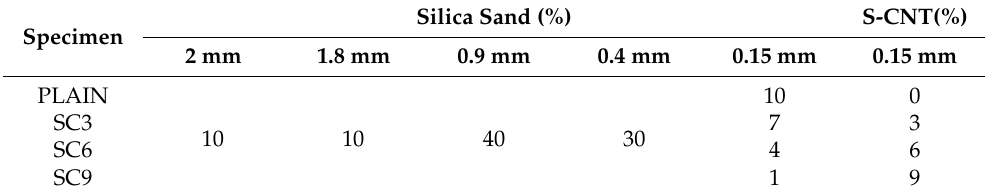
Table 3. Particle size distribution of silica sand (mass fraction).